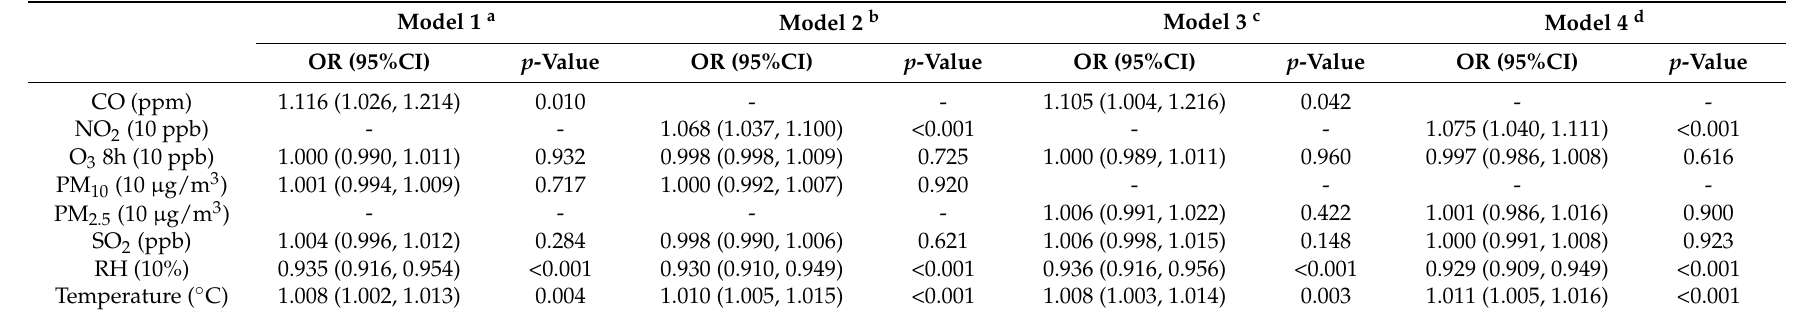
Table 3. Multivariate conditional logistic regression analyses between DED, air pollutants and meteorological